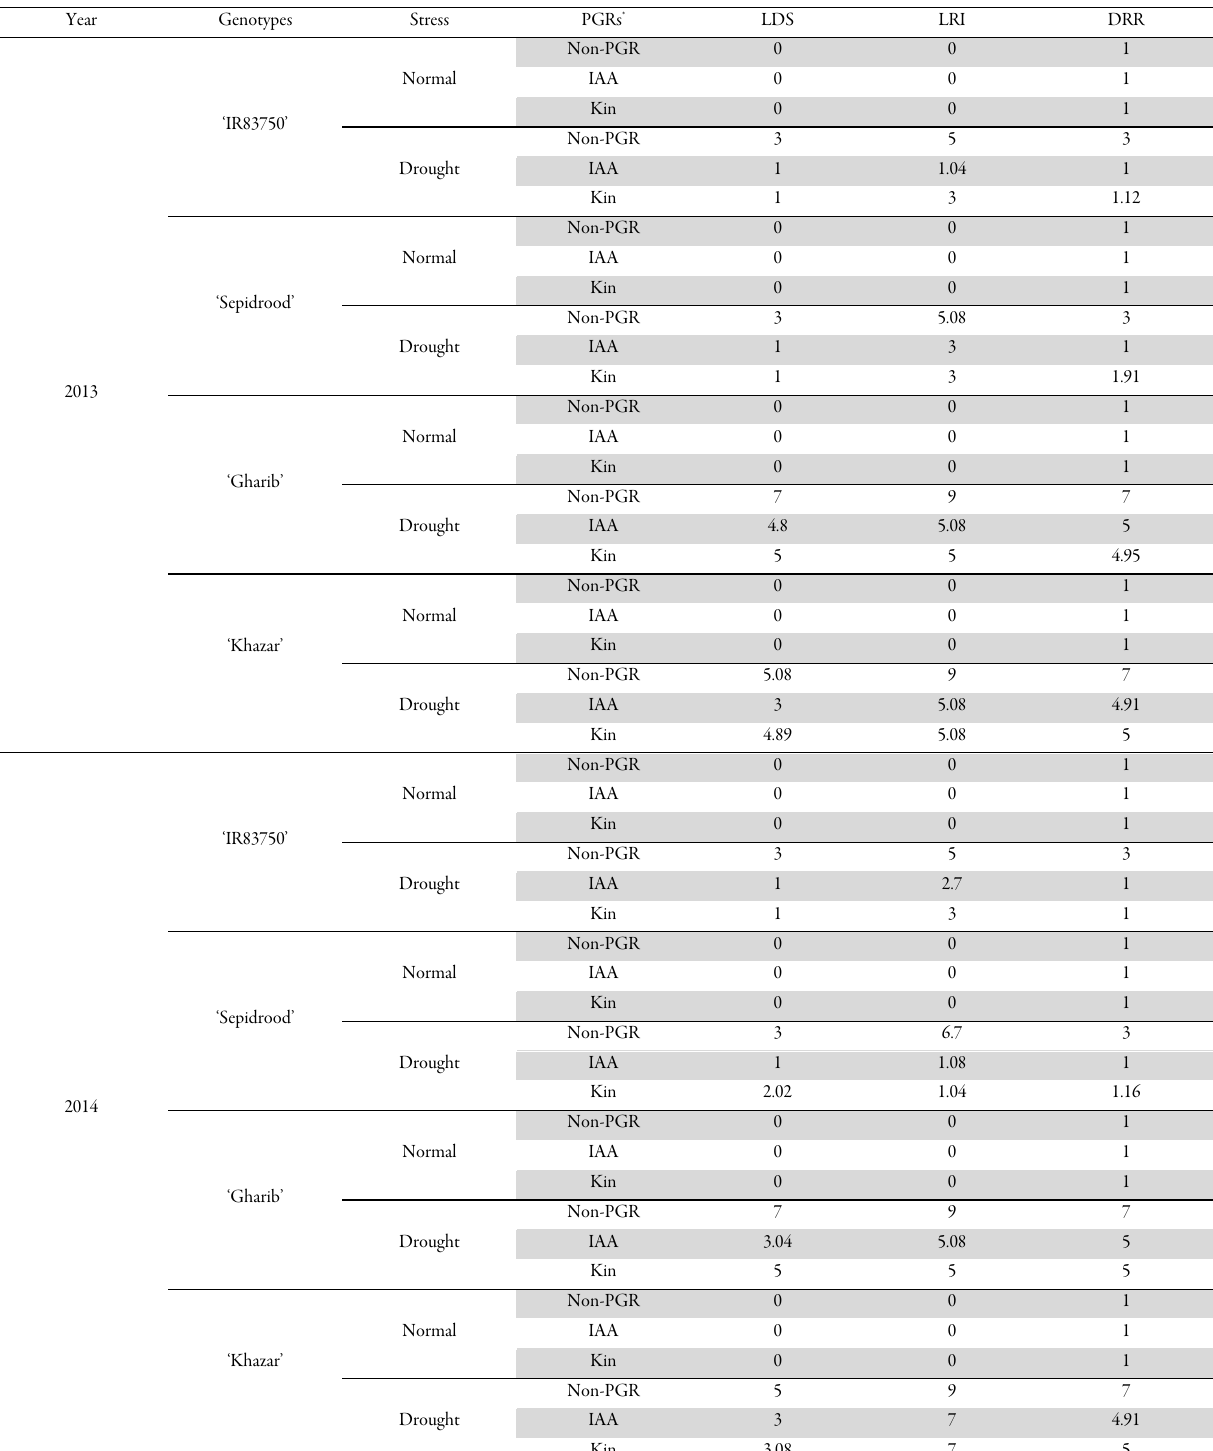
Table 5. Means of ordinal measurement traits in all examined genotypes under drought